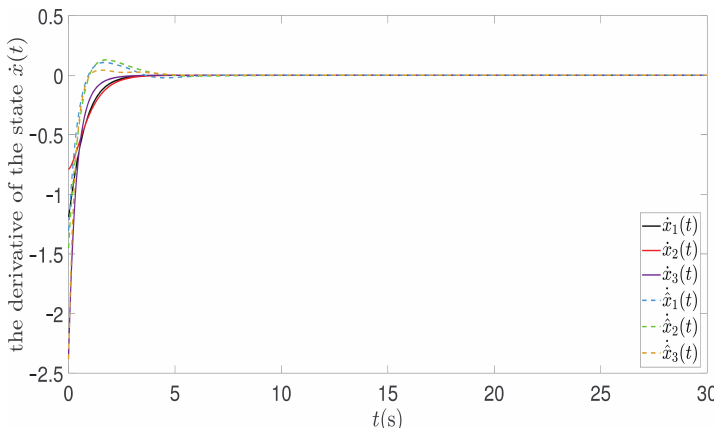
Figure 15. The derivative curves of the states and estimated